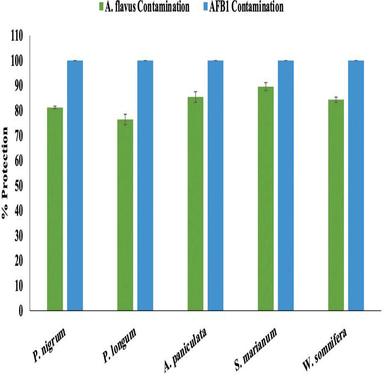
A. In-situ preservative efficacy of Ne-CIM: percentage inhibition of fungal growth and AFB1 contamination on]selected herbal raw materials during their 12 months of storage.